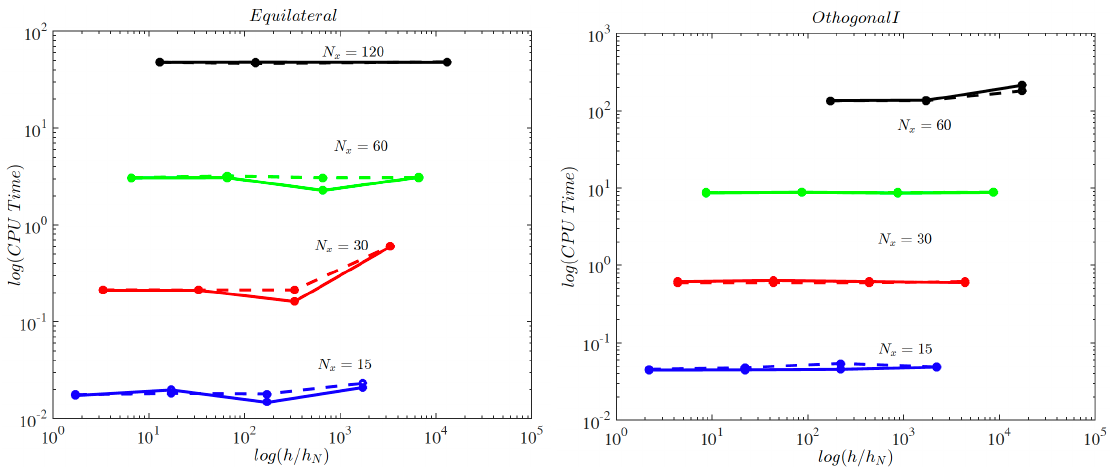
Figure 11. CPU time versus variable water depth for GMRES (solid line) and BiCGStab (dashed line) using ILU( k ) preconditioner and RCM reordering, for Equilateral type of grids ( left ) and for Orthogonal I types ( right ).